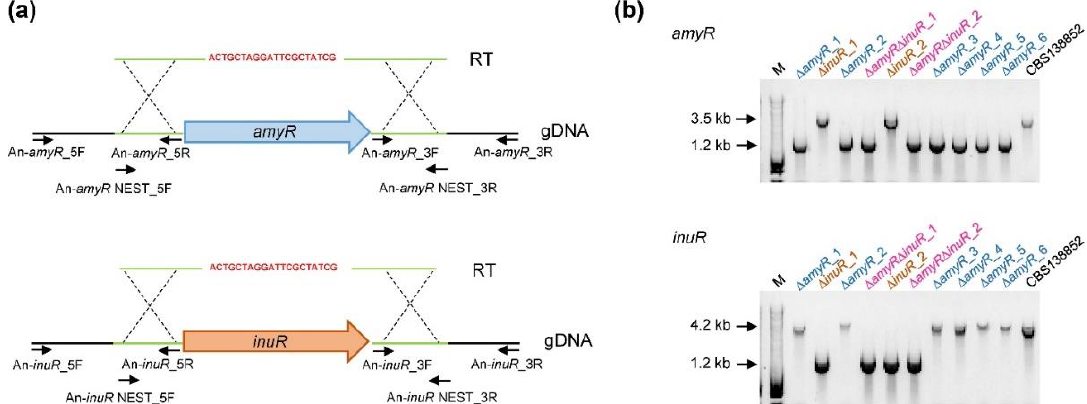
Figure 1. Molecular characterization of A. niger ∆ amyR , ∆ inuR and ∆ amyR ∆ inuR strains. ( a ) Schematic representation of the genomic DNA (gDNA) reparation by homologous recombination after Cas9 cleavage in the amyR (blue arrow) and inuR (orange arrow) genes. The ~600 bp complementary arms to the upstream and downstream regions of amyR and inuR are represented in green. To generate the repair template (RT), a 20-bp sequence (red) was introduced for complementarity during fusion PCR. Black arrows represent the primers used for RT generation and transformant confirmation by PCR (Supplementary Table S2). Figure is not drawn to scale. ( b ) PCR confirmation of the A. niger ∆ amyR , ∆ inuR and ∆ amyR ∆ inuR strains. Low bands (~1.2 kb) correspond to the deletants in amyR (top panel) and inuR (bottom panel), while upper bands (~3.5 and 4.2 kb) correspond to the parental strain (CBS 138852). Primer pairs used are located as indicated in the